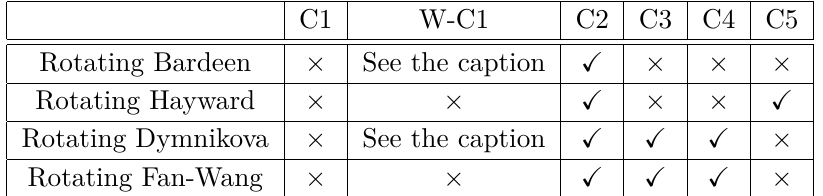
Table 7 . Results of geometric criteria C1–C5 in section 1 for rotating non-singular black holes with l > 0 . For the rotating Bardeen and Dymnikova black holes, the criterion W-C1 is satisfied if ( r, θ ) = (0 , π/ 2) is not a p.p. curvature